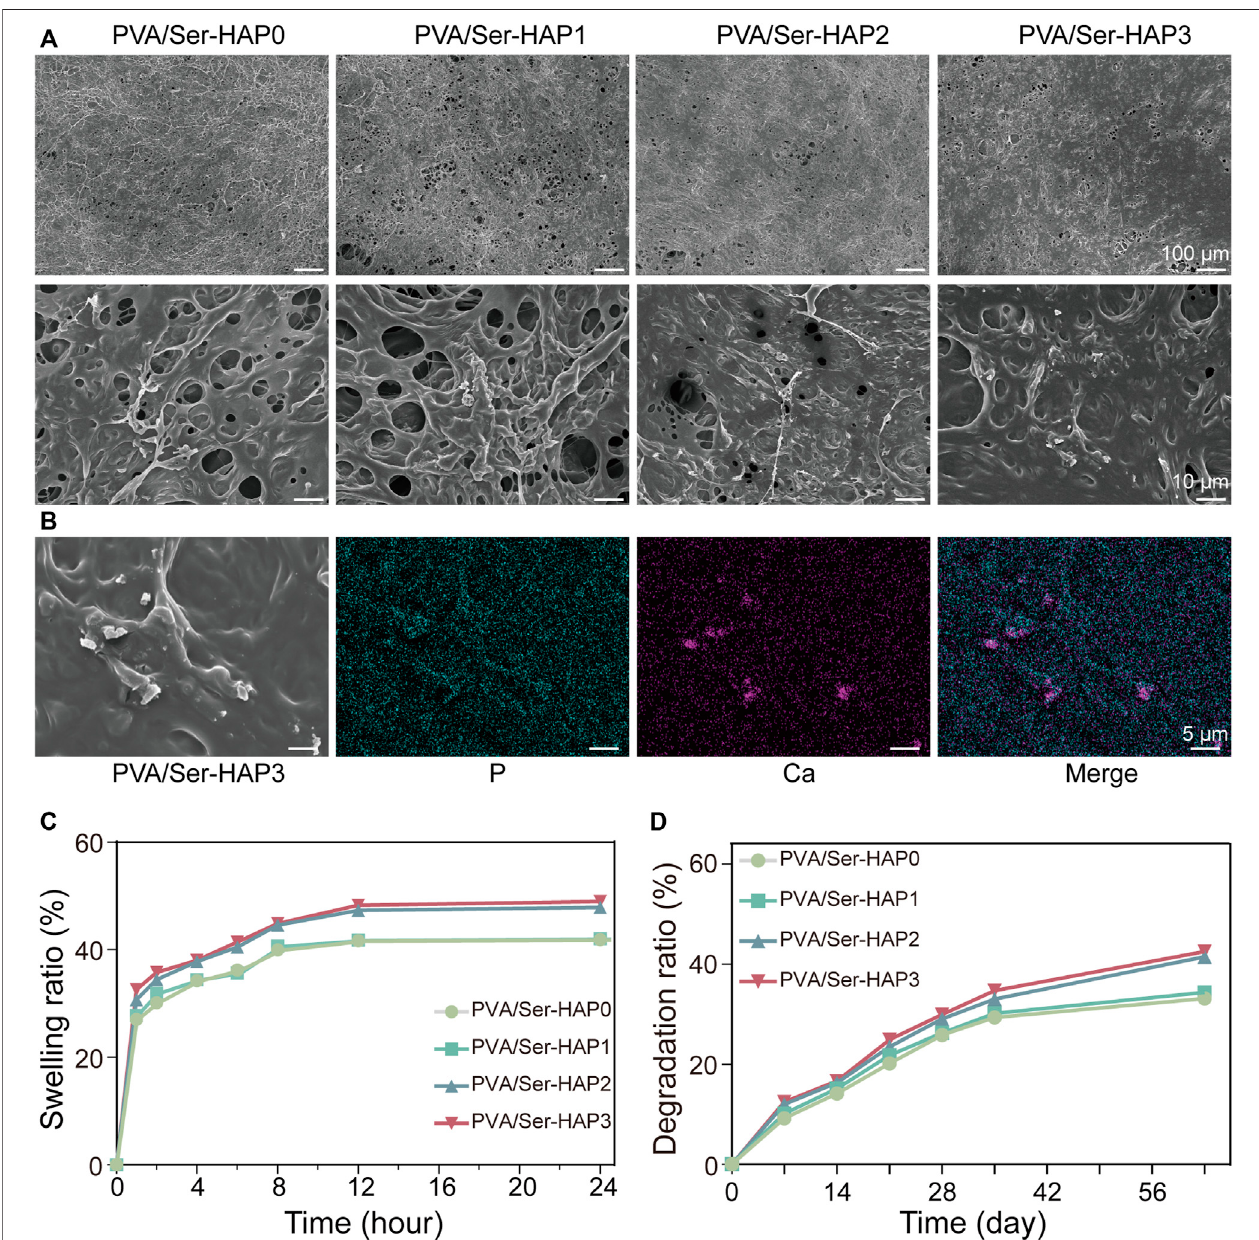
FIGURE5| SurfacemorphologyandcharacterizationofPVA/Ser-HAPmembranes. (A) SEMmicrographsofPVA/Ser-HAPmembranes; (B) Elementalmappingof P and Ca in the PVA/Ser-HAP3 membrane; (C) Swelling and (D) degradation of the PVA/Ser-HAP membranes.